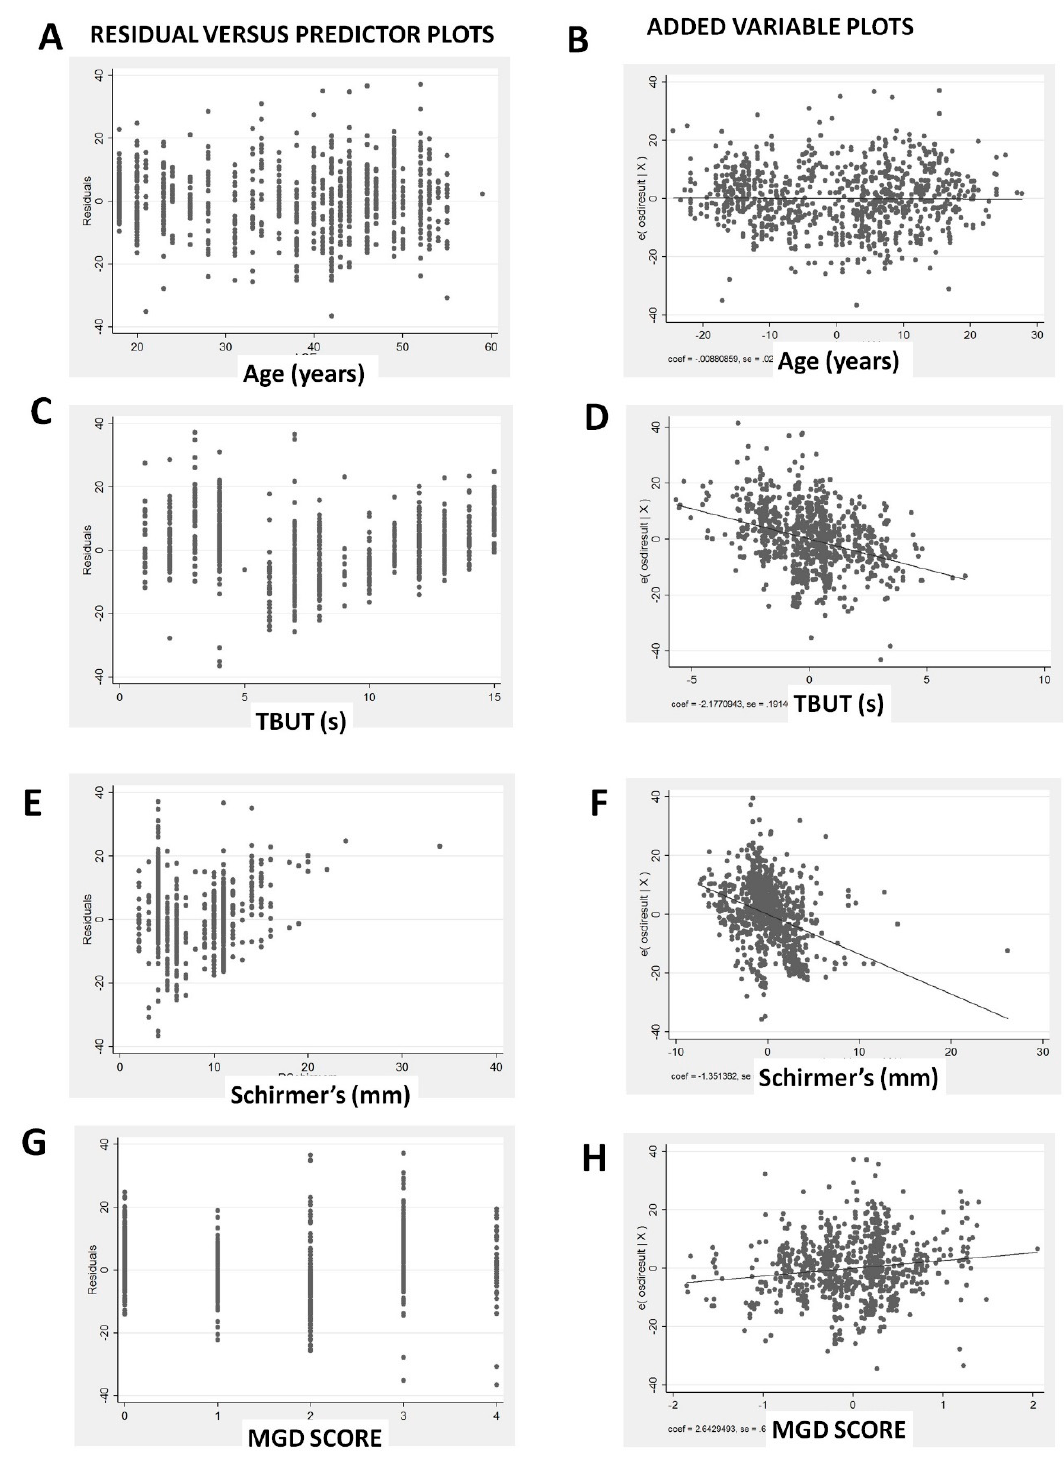
Figure 4. Graphs showing the residual versus predictor plots ( A , C , E , G ) and the added variable plots ( B , D , F , H ).